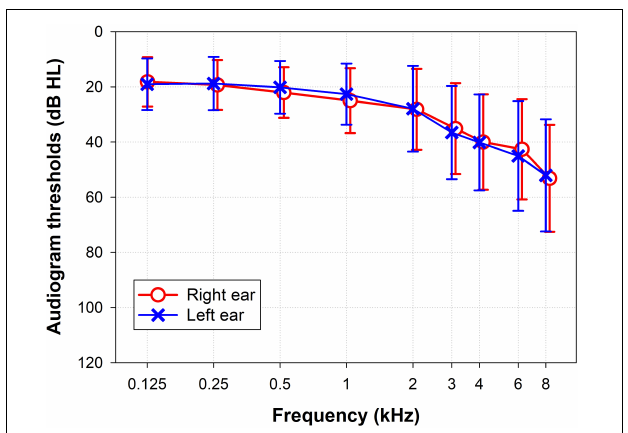
FIGURE 1 | Grand average audiogram for pure-tone thresholds expressed as mean and SD of the left (blue crosses) and right (red circles) ears.